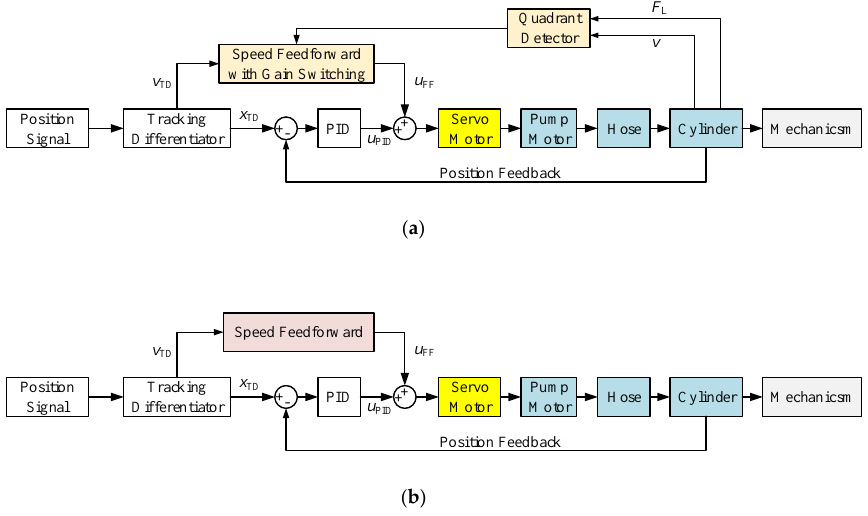
Figure 7. Schematics of closed-loop position control with speed feedforward plus PID: ( a ) SPC, ( b ) DPC.